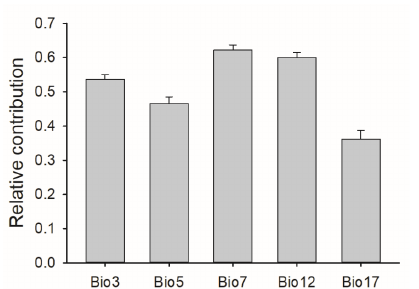
Figure 3. The relative contributions of selected predictor variables in the ensemble model of the habitat suitability of Paradoxornis heudei could be determined. bio3: mean diurnal range/temperature annual range; bio5: max temperature in the warmest month; bio7: temperature annual range; bio12: annual precipitation; bio17: precipitation in the driest quarter.